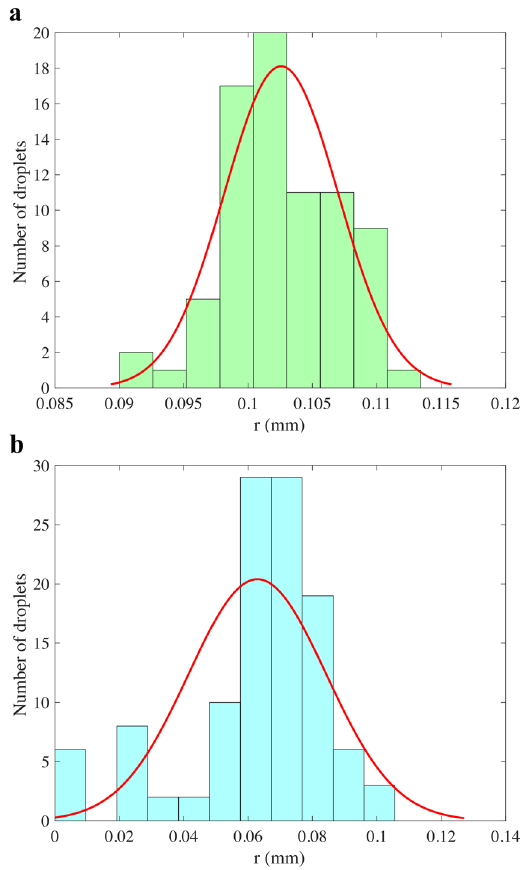
Figure 2. Example of size distribution of ejected droplets. ( a ) Histogram of the radius of ejected droplets for SiC, 5 wt% in H 2 O in microdripping mode ( φ 0 = 3000 V and H 1 = 2 mm). ( b ) Histogram of the radius of ejected droplets for SiC, 5 wt% in H 2 O in oscillating microdripping mode ( φ 0 = 4500 V and H 1 = 2 mm). The modes are color coded corresponding to Fig.